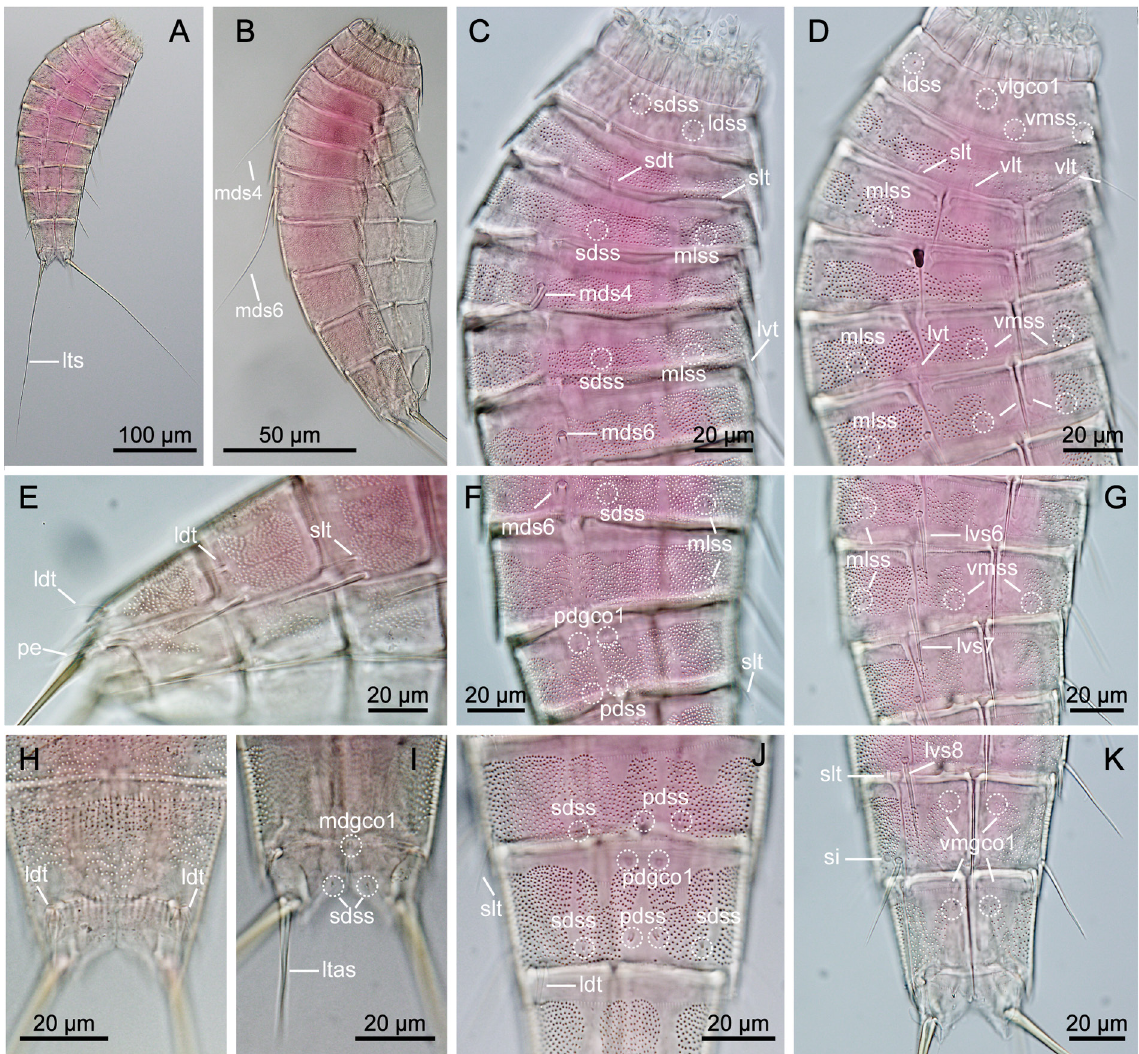
Fig. 9. Light micrographs showing overview and details of Echinoderes dalzottoi sp. nov. A, C–D, F–G, J–K . ♀, holotype (NIWA-159403). B, E, H–I . ♂, paratype (NHMD-917147). A .